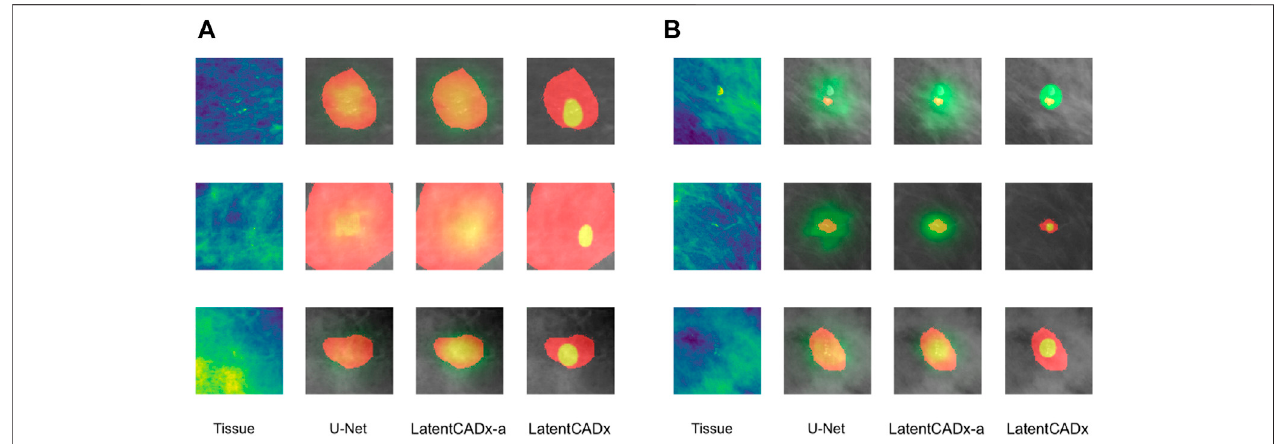
FIGURE 7 | Overlap between clinical annotations (red) and segmentation predictions are indicated as yellow. Segmentation predictions outside the ground-truth annotations are colorized in green. Columns left to right visualize the tissue image from the validation set, followed by segmentation predictions by four comparable modelsincludingLatentCADx. (A) ClarityinSegmentationsLatentCADxpredictedsegmentationswithclearboundariesandlocalizationbeyondthecoarseannotations. (B) Calci fi cationDetectionLatentCADxsegmentationscircumscribecalci fi cations whilecircumscribingminimalamountsofhealthytissue(Mammogramsobtained from (Lee et al., 2006); CC BY open access